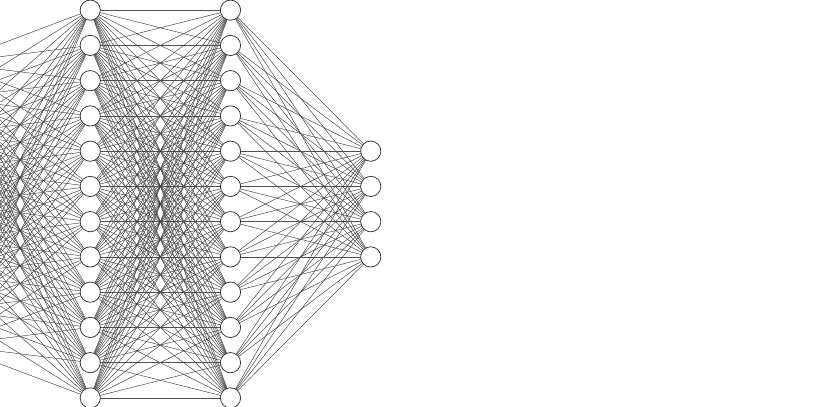
Figure 2. Schematic of a deep neural network with an input layer capable of accepting a nine feature input vector, two hidden layers each with 12 neural network nodes, respectively, and an output layer of 4